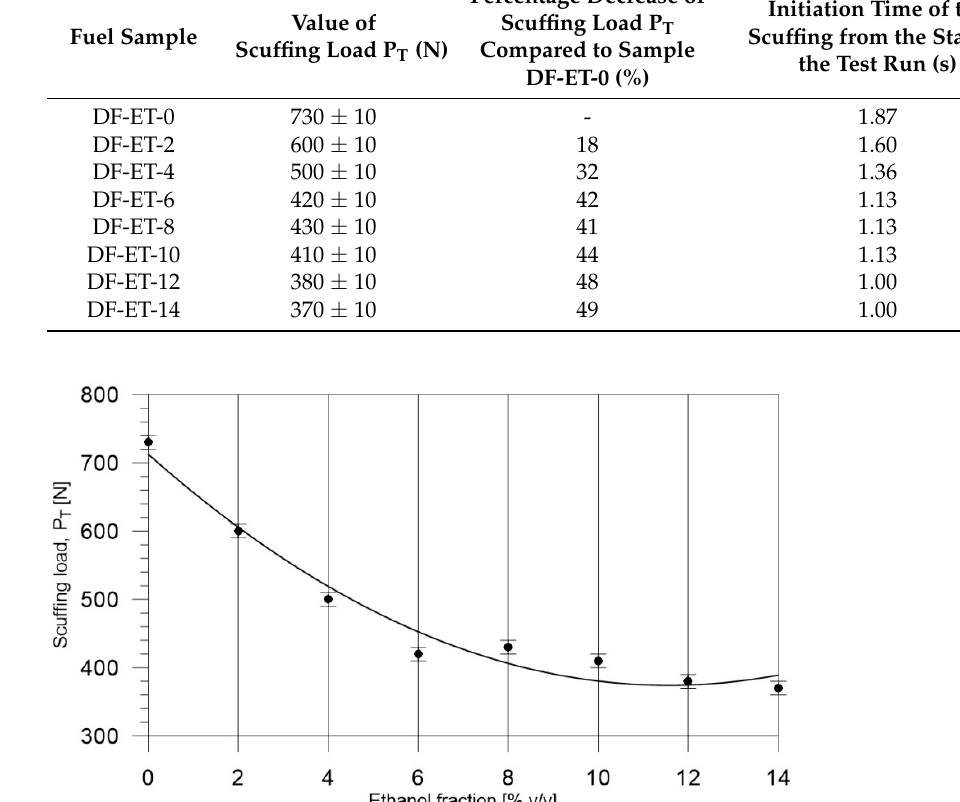
Figure 12. Effect of ethanol volume fraction in a diesel–ethanol blend on the scuffing load, P T